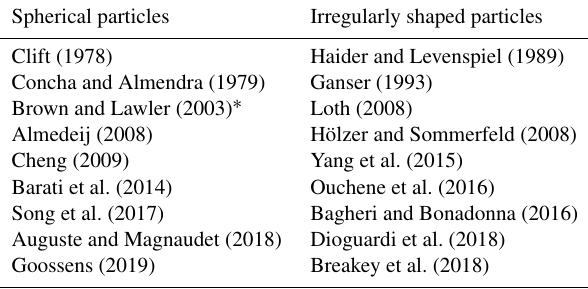
Table 1. Publications with overviews of drag coefficient models. Spherical